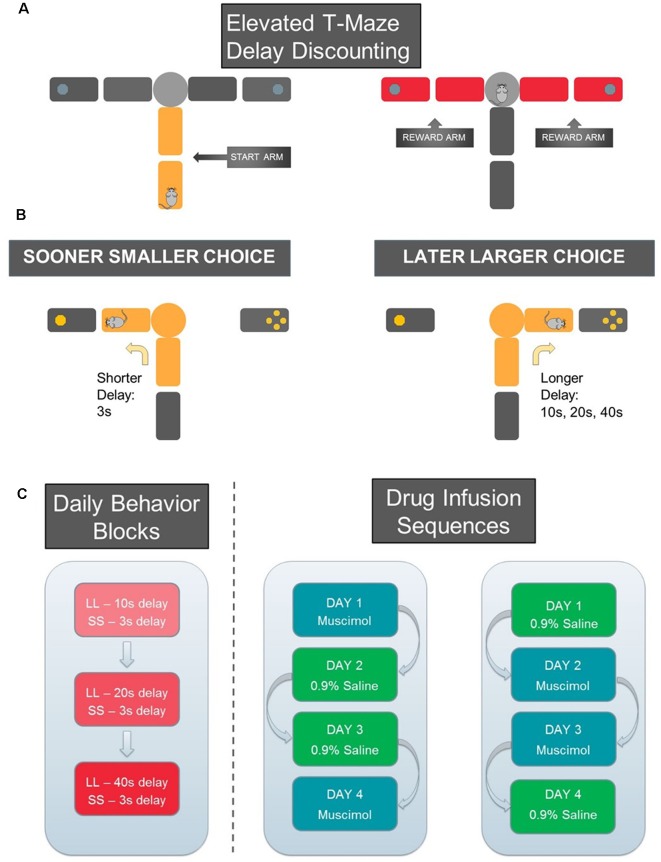
Schematic of Delay-Discounting Task. (A) Reward arm (marked in yellow) and two start arms (marked in red) on the elevated T-maze. (B) Sooner smaller choice: the animal waited for 3 s to obtain one sugar pellet. Later larger choice: the animal waited for 10 s and obtained four sugar pellets. Once the animal entered one reward arm, the other reward and start arms were blocked by wooden barriers to confine the animal to the chosen arm for the entire delay period. (C) For each day of testing, three blocks of trials were offered, each associated with a different length of LL delay (10 s, 20 s, or 40 s). The SS delay remained constant (3 s). The blocks were separated by an inter-block interval of 5 min. Drug infusion sequences follow an ABBA pattern. On day 1 and day 4, a certain animal would receive one type of infusion (0.9% saline or muscimol), and day 2 and day 3 of the alternative type of infusion.